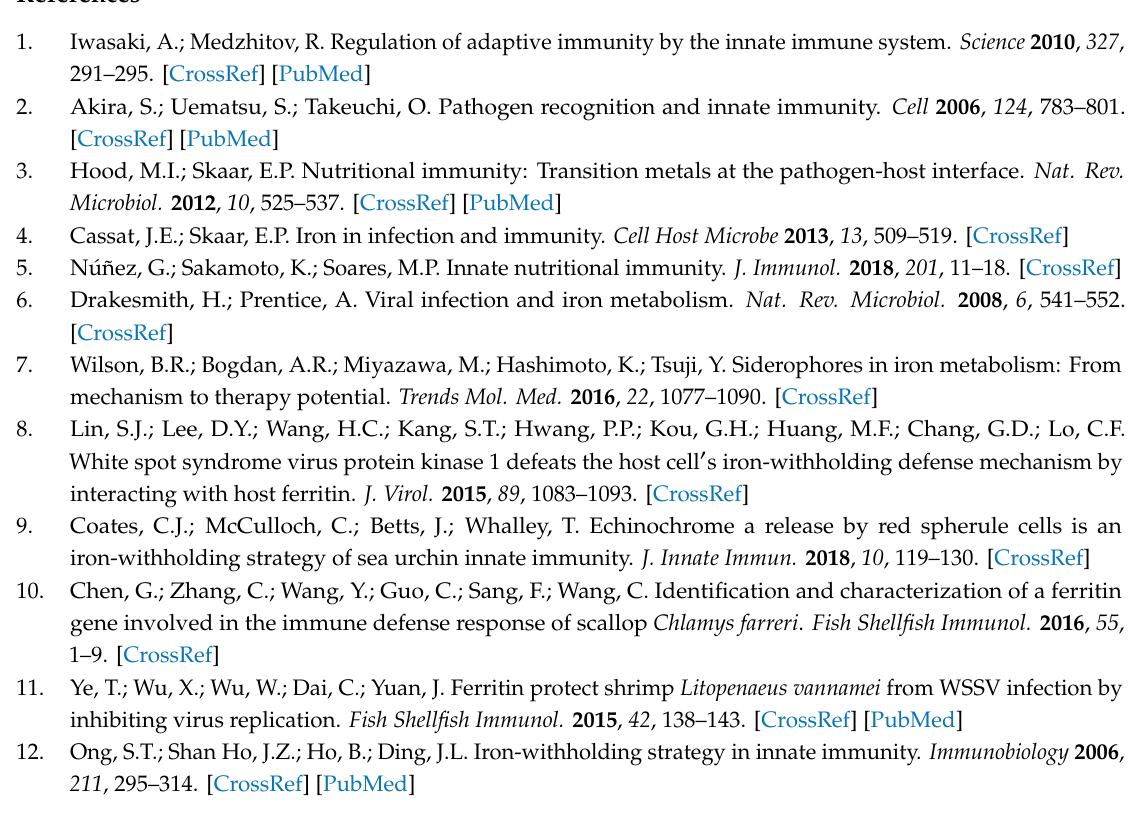
macrophages. Figure S2: Observation results for verifying the promoter activity of the 5 (cid:48) -flanking region of CiTfR1 by fluorescent microscopy. Figure S3: Preparation of rabbit anti-CiTfR1 polyclonal anti-serum and verification of the recognition specificity. Figure S4: CiTfR1 enhances the intracellular oxidative stress in grass carp macrophages upon GCRV